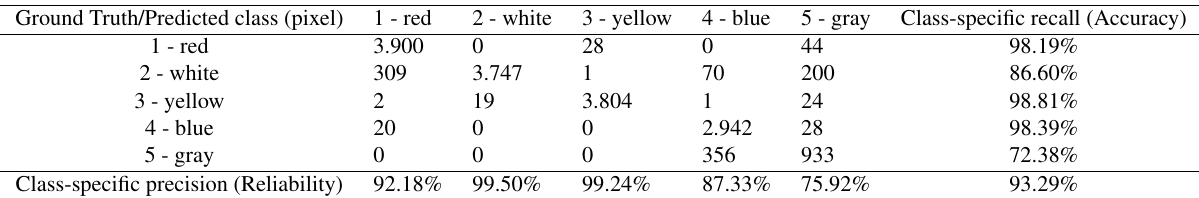
Ground Truth/Predicted class (pixel)